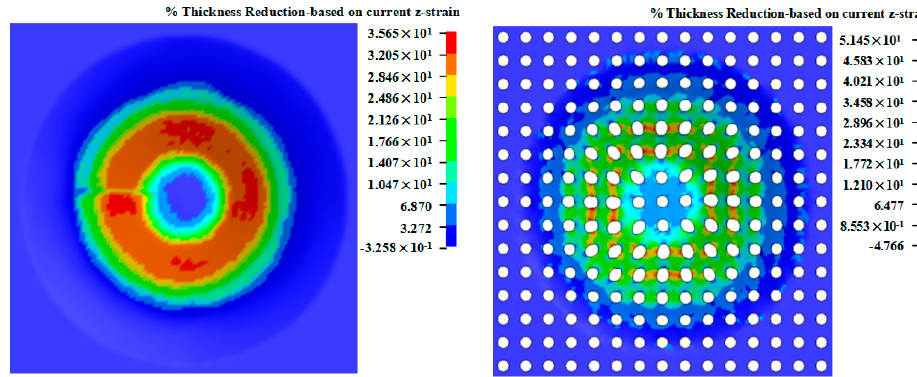
Figure 11. Cloud image of the thinning rate of titanium plate and perforated titanium sheet.